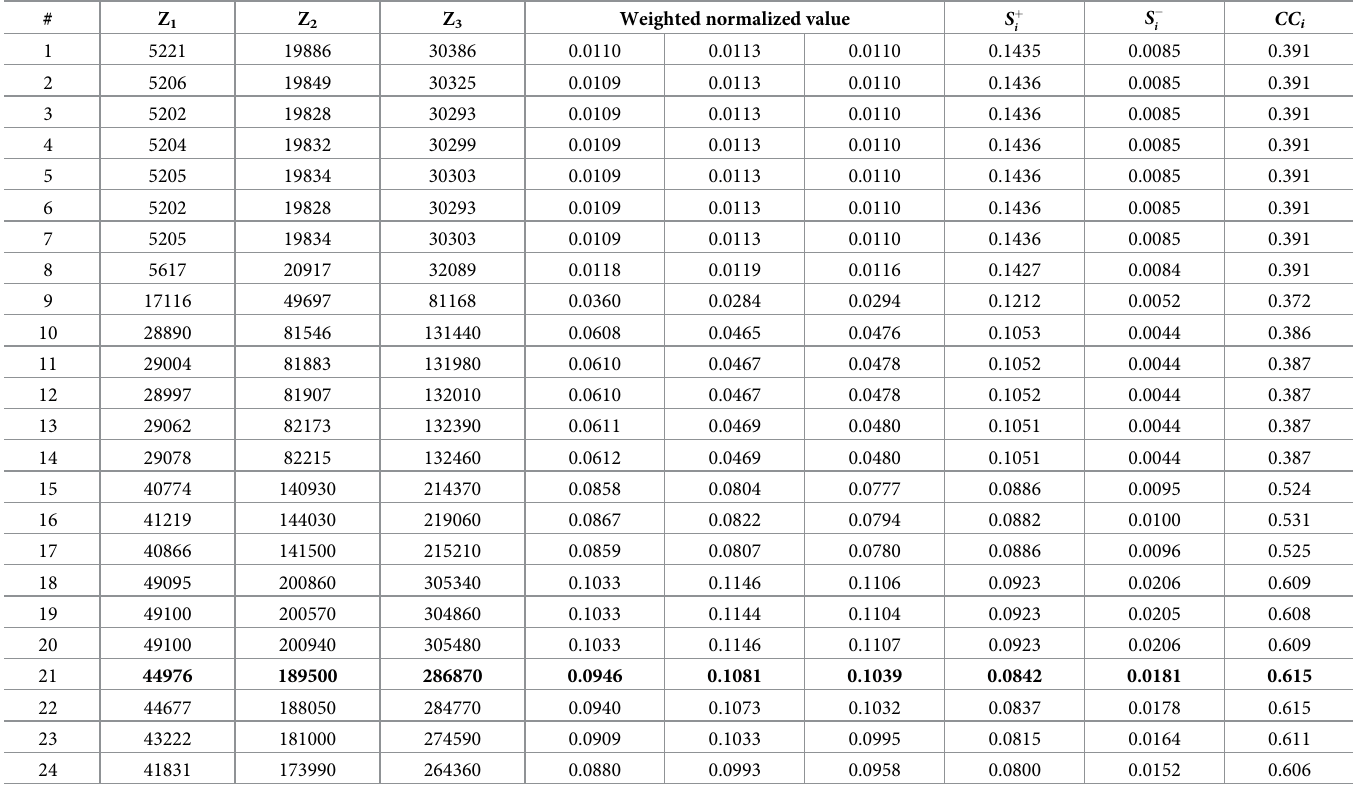
Table 15. TOPSIS calculation result for α = 0.5.